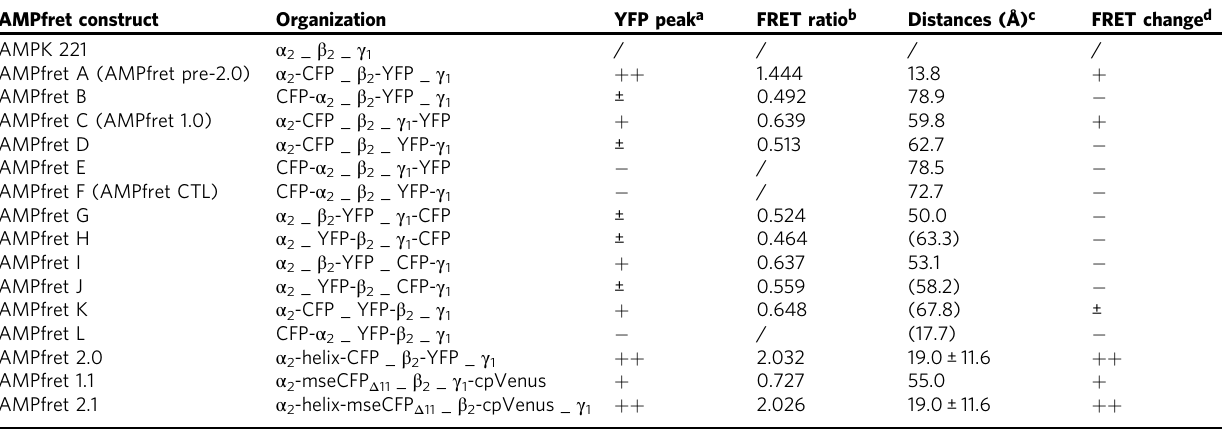
Table 1 Overview of AMPfret constructs tested for AMP responses AMPfret